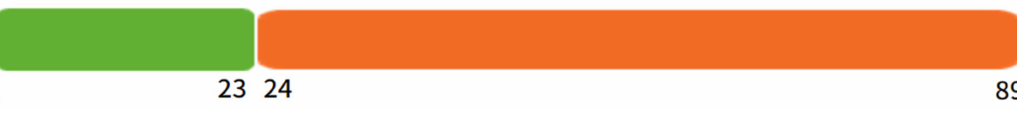
Figure 9. The prediction result of IAPP based on DisPort.